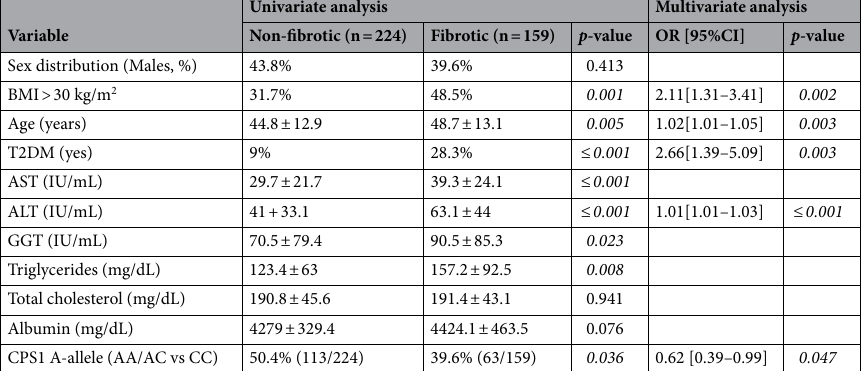
Table 2. Multivariate analysis of factors independently associated with liver fibrosis. BMI body mass index, T2DM type 2 diabetes mellitus, AST aspartate aminotransferase, ALT alanine aminotransferase, GGT